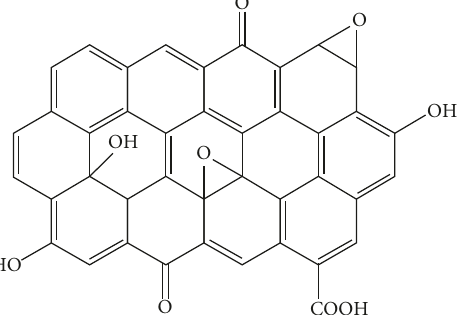
Figure 14: Chemical structure of graphene oxide.